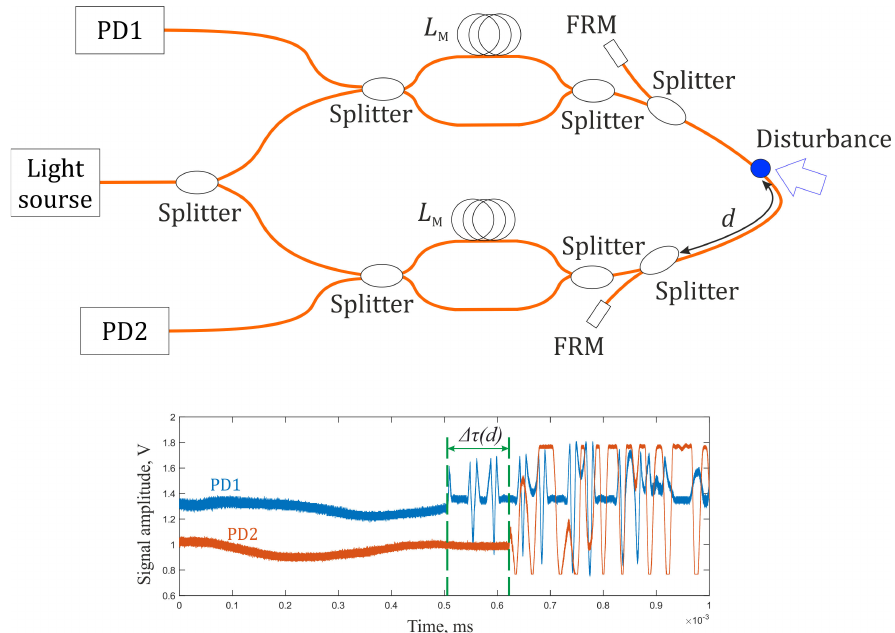
Figure 3. Diagram of a counter loops method